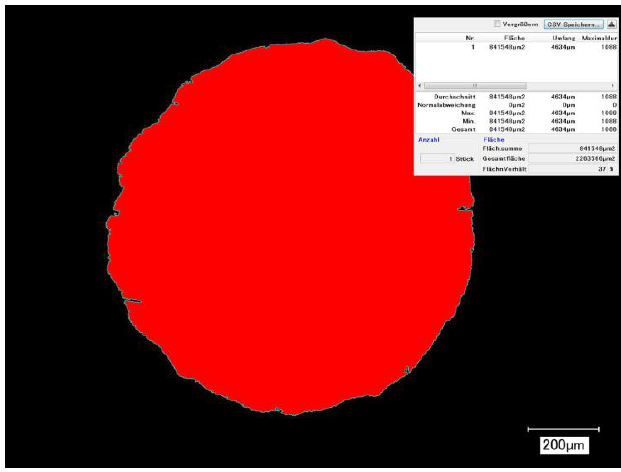
Figure 7. Sample of cross section area and the measured area for the determination of the equivalent diameter. In this picture, a 0° oriented SLM part is seen.